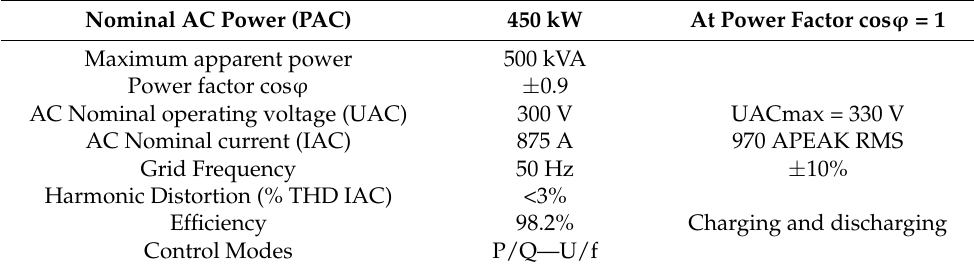
Table 4. Main technical characteristics of the Indrivetec SOLO S inverter.